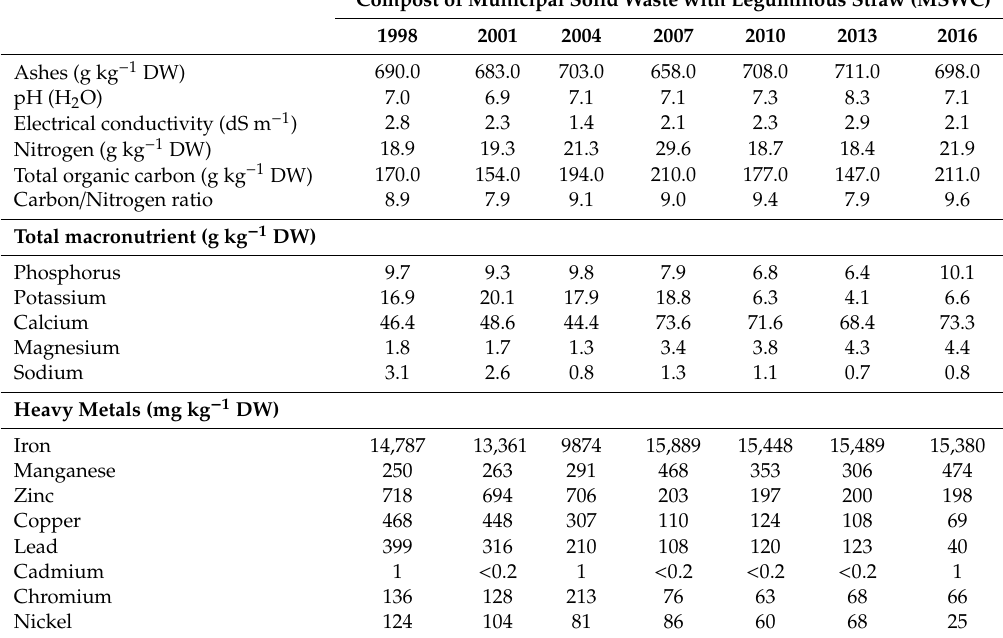
Figure 2. Scheme of the block distribution of treatments in the field experiments. Table 3. Main analytical characteristics of the compost obtained from the mixture of municipal solid waste with legume straw (MSWC) and applied to the soil in the years of study.